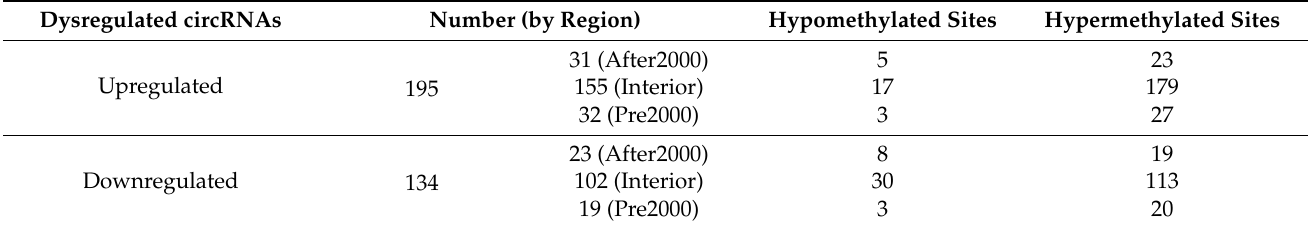
Table 3. Summary of differentially expressed circRNAs associated with differentially methylated sites in HCC. Dysregulated circRNAs Number (by Region) Hypomethylated Sites Hypermethylated Sites 31 (After2000) 5 23 Upregulated 195 155 (Interior) 17 179 32 (Pre2000) 3 27 23 (After2000) 8 19 Downregulated 134 102 (Interior) 30 113 19 (Pre2000) 3